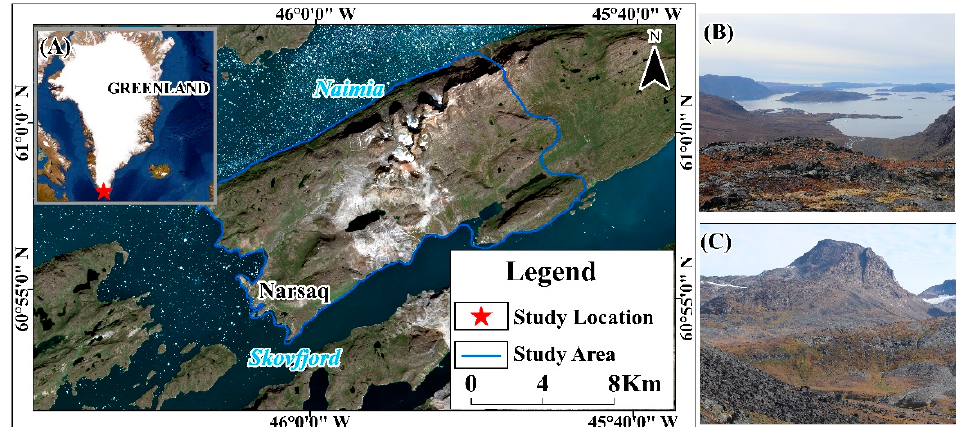
Figure 1. ( A ) Location map based on Sentinel-2 ′ s true color 432 band combinations; ( B , C ) A realistic view of the study area environment.